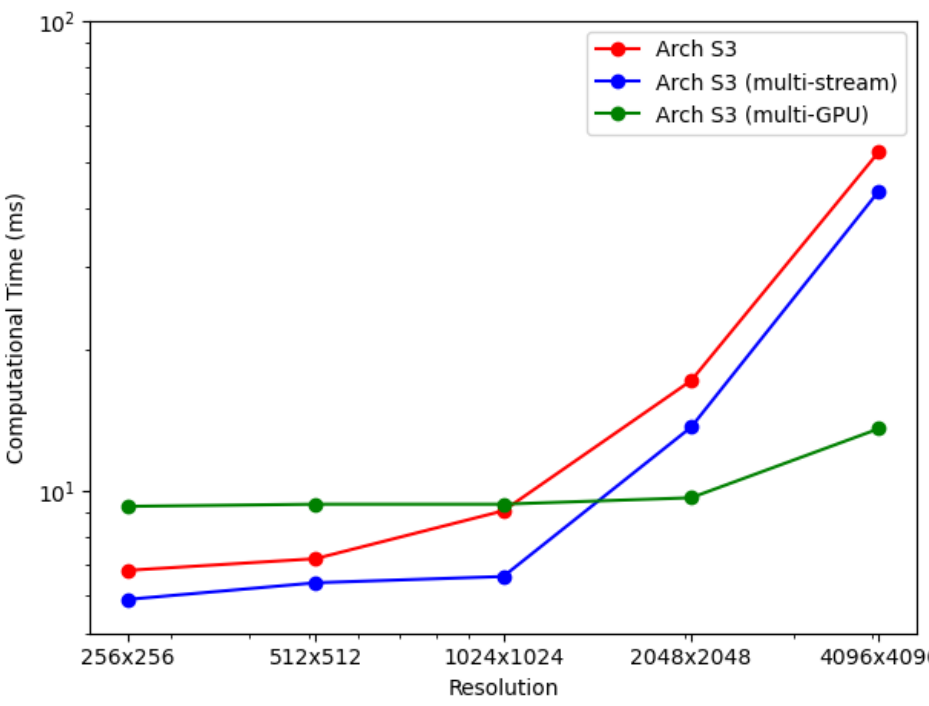
Figure 13. Performance comparison: multiple stream and multi-GPU